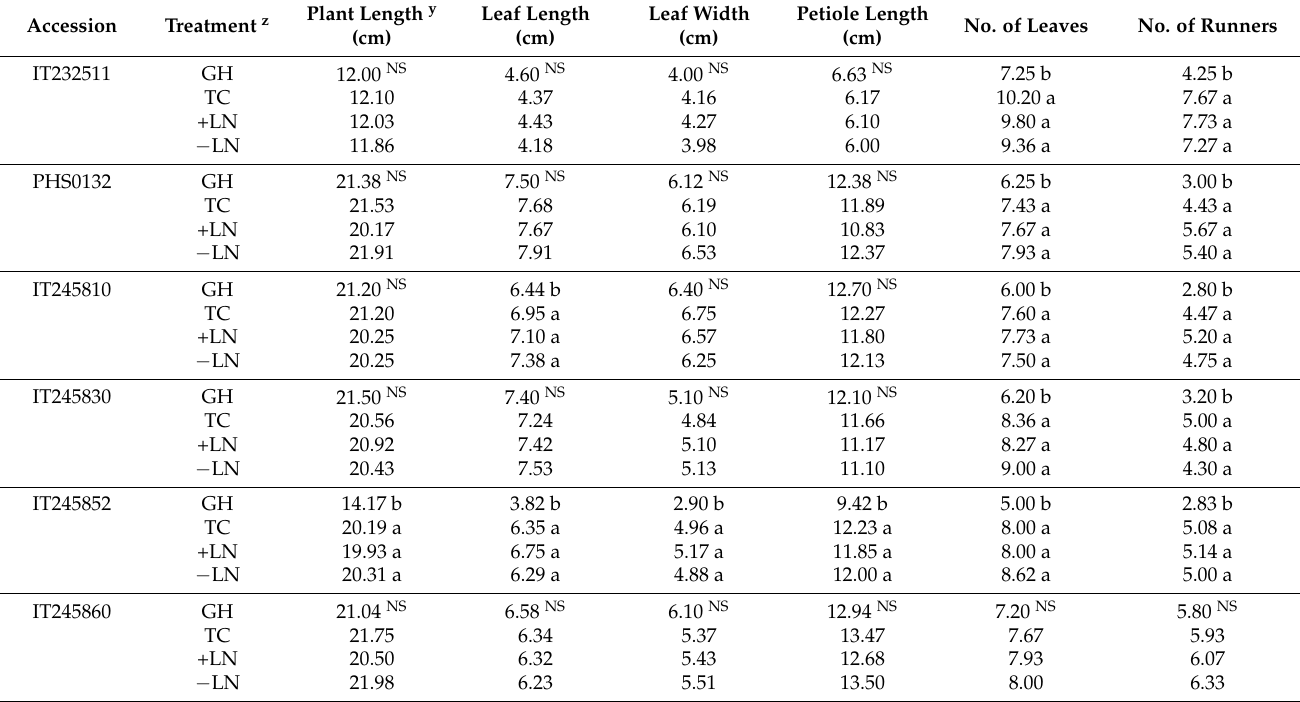
Table 3. Effects of four treatments on six vegetative traits for six strawberry accessions.